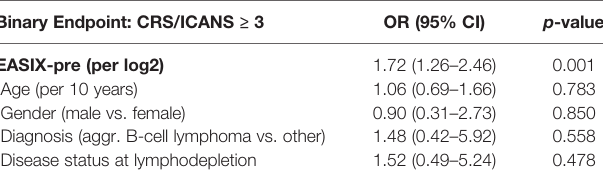
EASIX ,Endothelial Activation and Stress Index; pre, prior lymphodepletion; log, logarithm; CRS, cytokine release syndrome; ICANS, immune effector cell-associated neurotoxicity syndrome; OR, odds ratio; 95% CI, 95 percent con fi dence interval. Diagnosis patients with aggressive B-cell lymphoma vs. other. Disease status: patients with progressive or refractory disease vs. patients with stable disease or response (complete or partial).